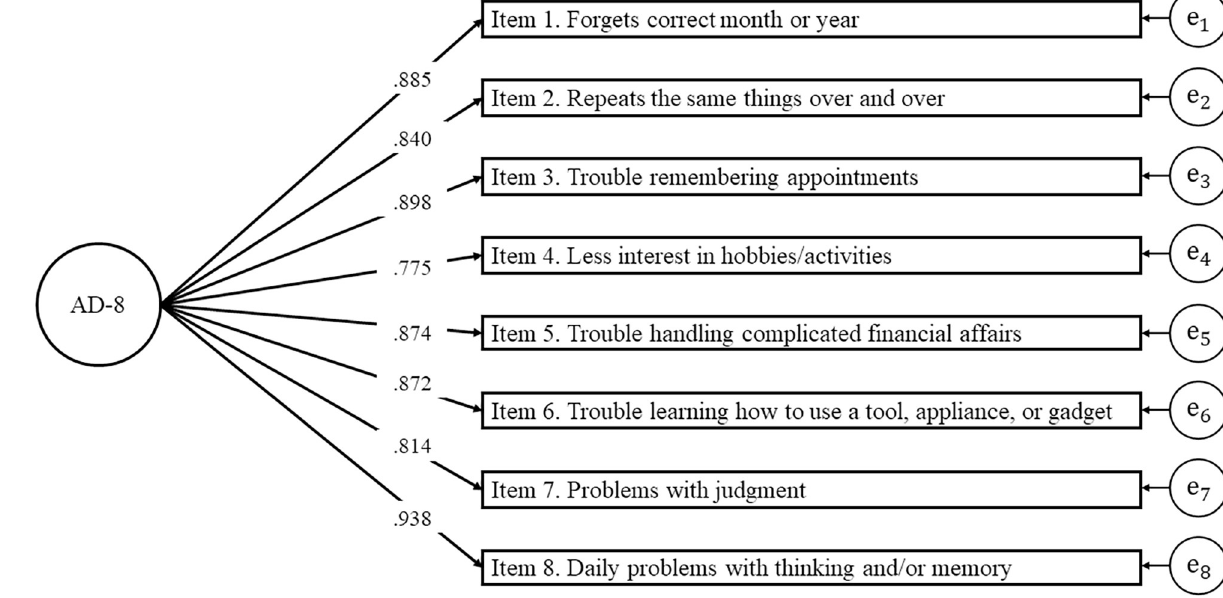
Fig 2. The diagram of confirmatory factor analysis for the